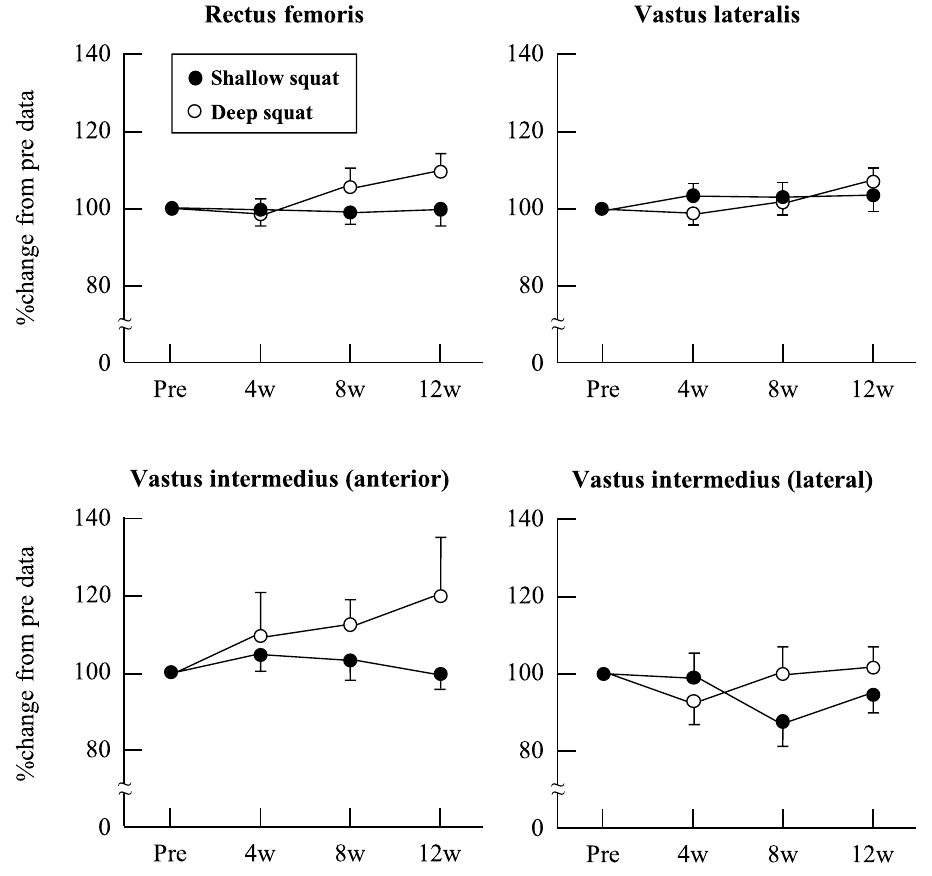
Figure 3. Relative changes in muscle thickness as a result of squat training in the shallow squat and deep squat groups. Error bars show standard error